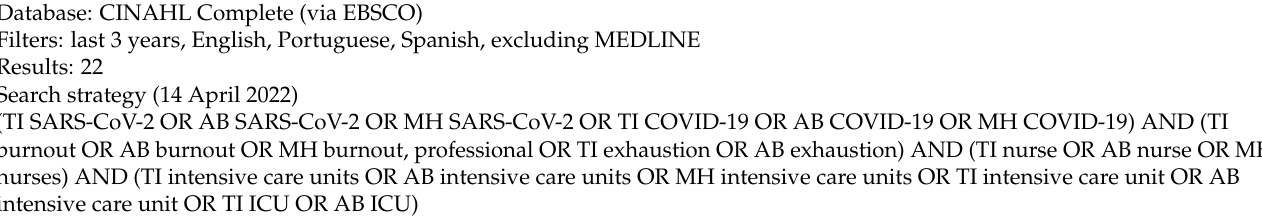
Table 1. Database search strategy and